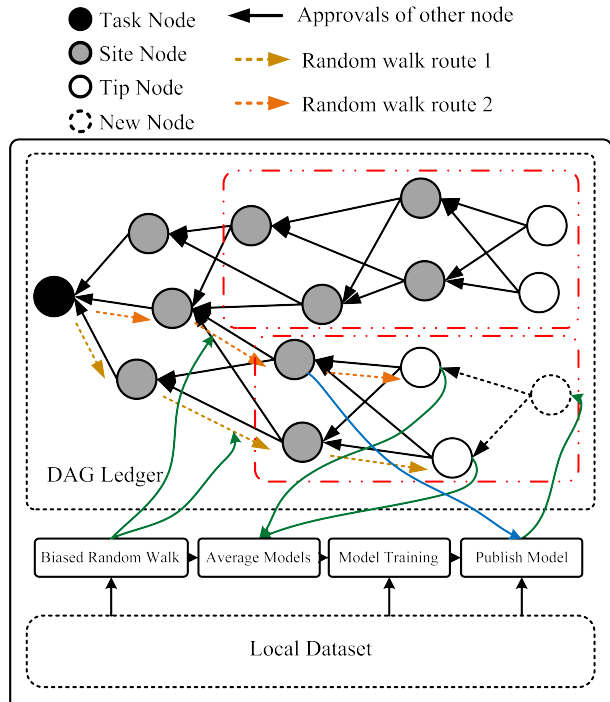
Figure 1. Basic principle of